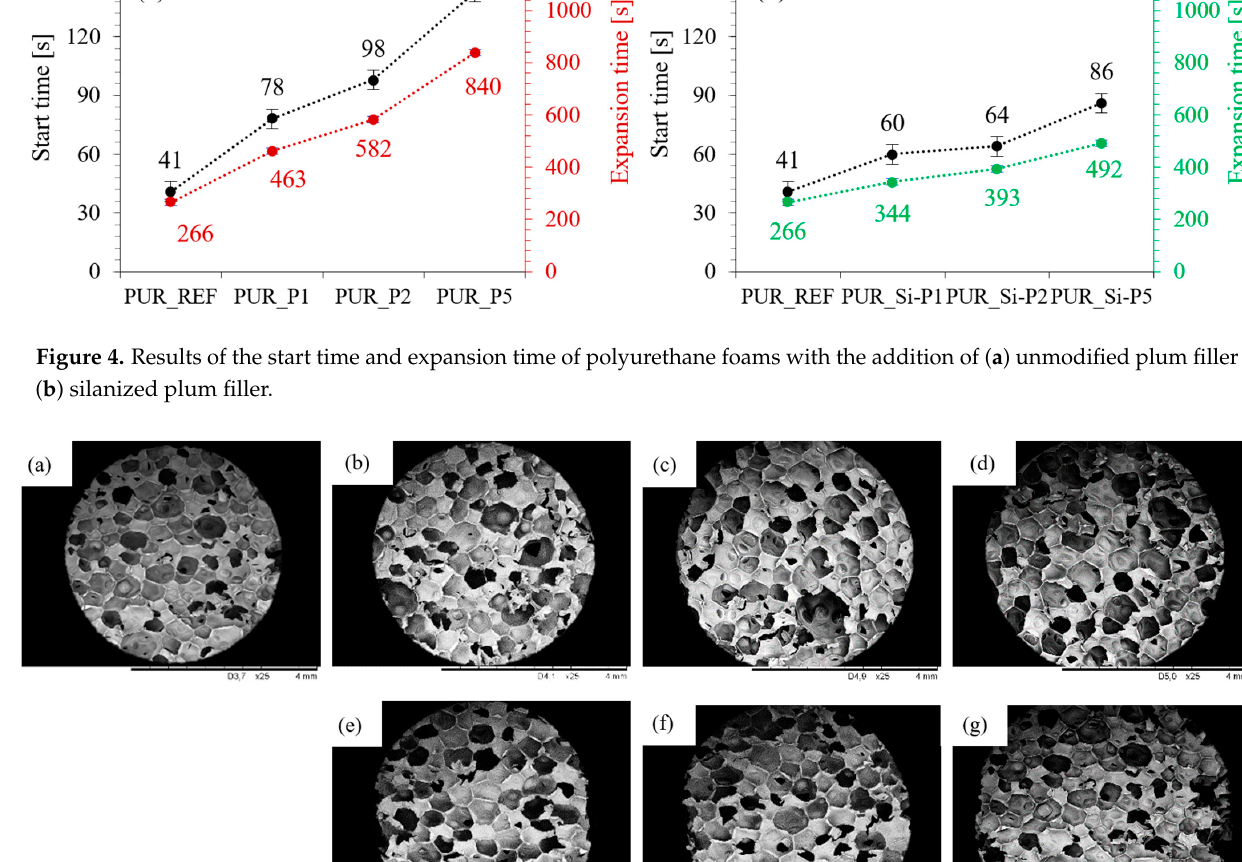
Table 1. Rheological and structural properties of polyurethane foams.